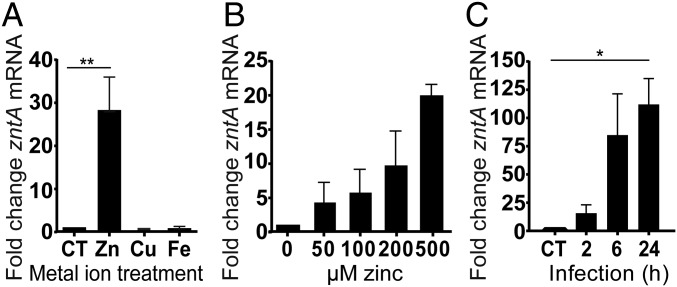
UPEC strain EC958 is exposed to zinc stress within the intramacrophage environment. (A) EC958 was incubated for 6 h in complete RPMI media containing 500 µM ZnSO4, CuSO4, FeSO4, or water (control, CT), after which zntA mRNA levels, relative to gapA, were determined by quantitative real-time PCR. Data (mean + SEM, n = 3), expressed as fold-change compared with the control, are combined from three experiments (**P < 0.01, one-way ANOVA and Dunnetts’s multiple comparisons test). (B) EC958 was incubated as above in increasing zinc concentrations. Levels of zntA mRNA (relative to gapA) were determined by quantitative real-time PCR. Data (mean + range, n = 2), expressed as fold-change compared with the control, are combined from two experiments. (C) HMDM were infected with EC958 (MOI of 100) for 1 h, whereupon extracellular bacteria were removed by gentamicin exclusion. Cells were lysed at 2, 6, or 24 hpi, after which RNA was extracted. Levels of zntA mRNA, relative to gapA, were determined by quantitative real-time PCR. Bacteria were cultured for 2 h in complete RPMI media alone as a control. Data (mean + SEM, n = 3), expressed as fold-change compared with the control, are combined from three experiments (*P < 0.05, one-way ANOVA and Dunnett's multiple comparisons test).